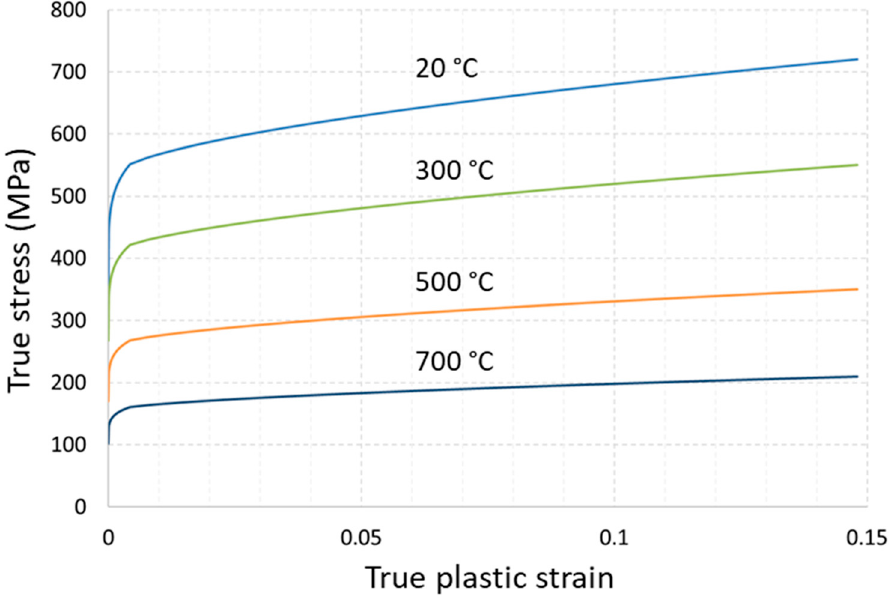
Figure 7. Temperature scaling of modified hardening behavior (MPa). Data for 20 °C are based on tensile experiments for horizontal sets.